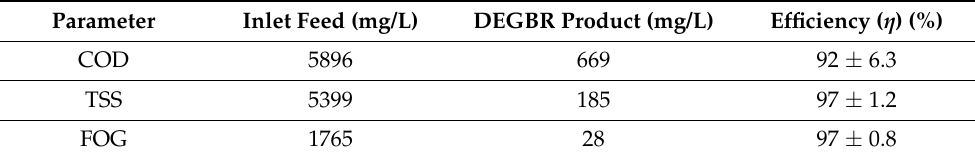
Table 2. Overall performance of the biological pre-treatment coupled with